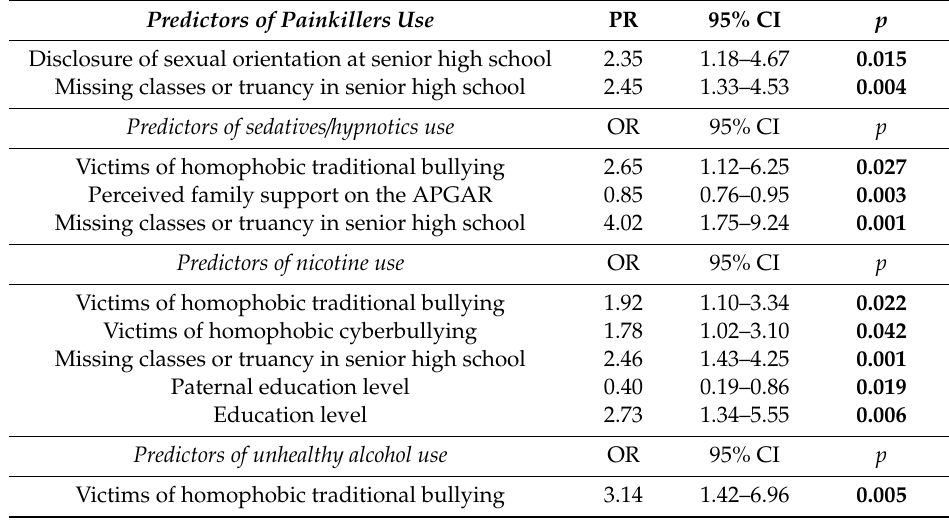
Table 6. Predictors of painkillers, sedatives / hypnotics, nicotine, and unhealthy alcohol use examined using forward stepwise logistical